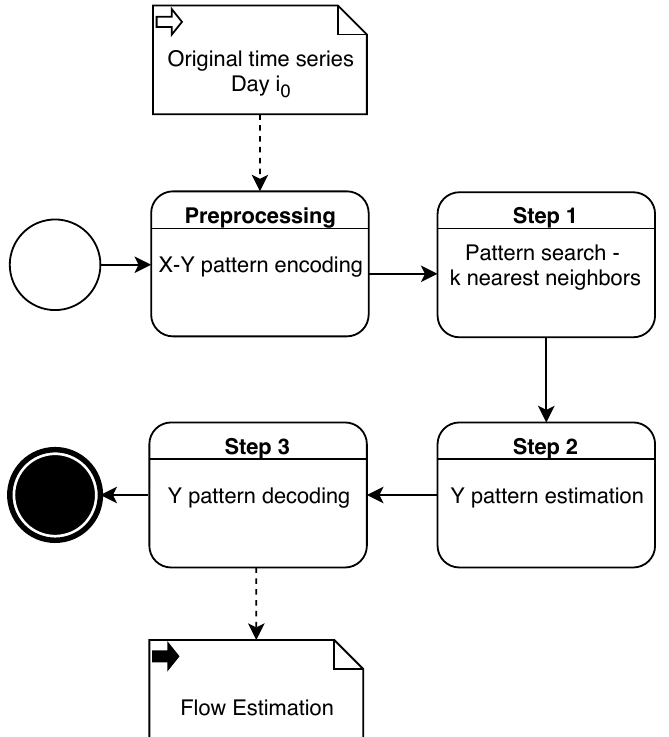
Figure 2. Flow-chart of the algorithm